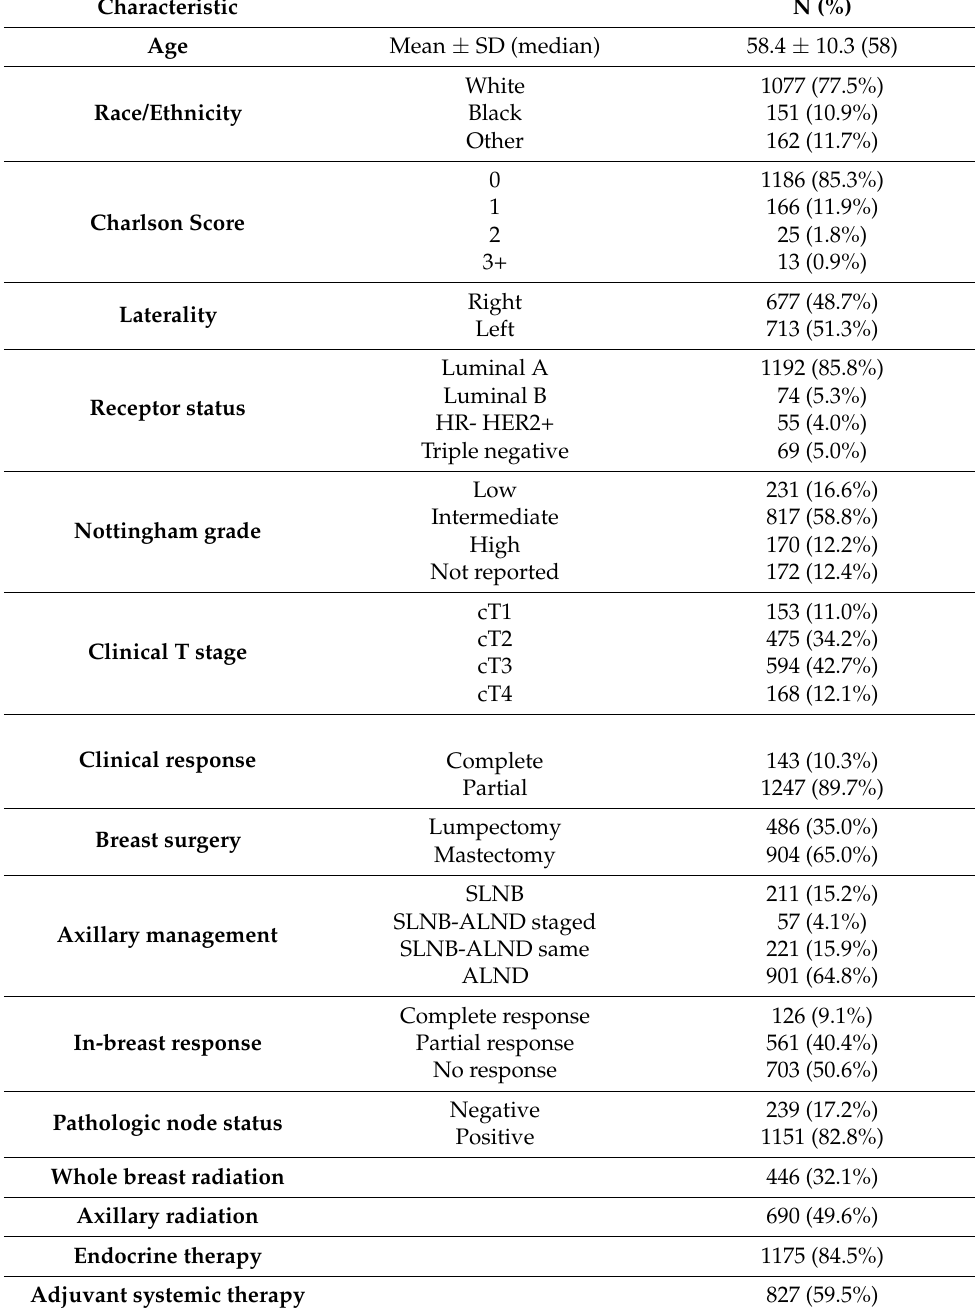
Table 1. Demographic and perioperative characteristics of the selected cohort ( N = 1390). Luminal A: designates an estrogen positive tumor; Luminal B: designates an estrogen negative tumor; ALND: Axillary Lymph Node Dissection; NOS: Not otherwise specified; SD: Standard Deviation; SLNB: Sentinel Lymph Node